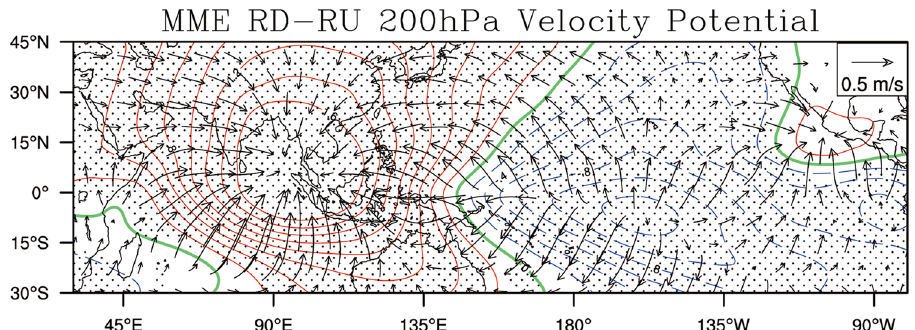
Fig. 5 The response of the velocity potential and divergence winds at 200 hPa. The difference in the velocity potential (color lines; unit: 10 6 m 2 s − 1 ) and divergence winds (vectors; unit: m s − 1 ) at 200 hPa between the RU and RD periods. The black dots denote the region in which at least 70% of models agree on the sign of the